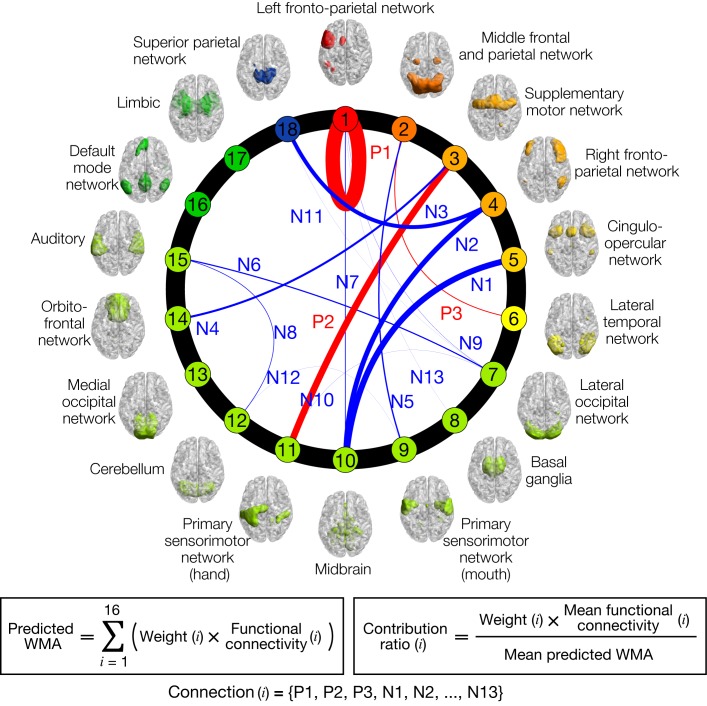
Normative model of working memory ability (WMA).Circle plot of networks and their connections in the model. Individual letter 3-back learning plateaus are predicted by a linear weighted summation of 16 FC values at 16 connections selected by a sparse linear regression algorithm. Connection thicknesses indicate contribution ratios (weight x FC at each connection). Connections are labeled ‘Positive/Negative (P/N)’ based on correlation coefficient signs with letter 3-back learning performances, whereas numbers indicate descending orders of contribution ratio. Each network’s color indicates relevance with working memory function based on BrainMap ICA (Laird et al., 2011); warmer colors indicate closer relevance to working memory function. See Table 1 for the networks connected by the selected 16 connections, and precise values of contribution ratio of each connection. Each network’s label and regions included in it are summarized in Supplementary file 2.